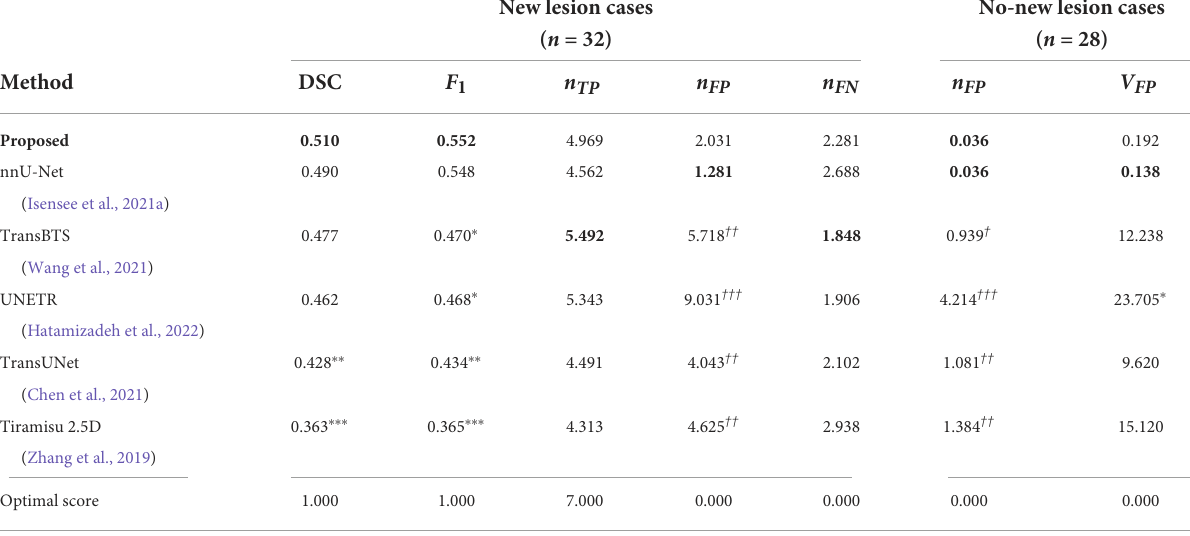
The methods are sorted in the descending order of DSC. Best results are in bold. Asterisks indicate statistical significance ( ∗ p ≤ 0.05, ∗∗ p ≤ 0.01, and ∗∗∗ p ≤ 0.005) when using a paired Student’s t -test compared to our proposed method. We implement the Mann-Whitney U -test for n TP , n FP , and n FN metrics due to their non-normal distribution. The dagger